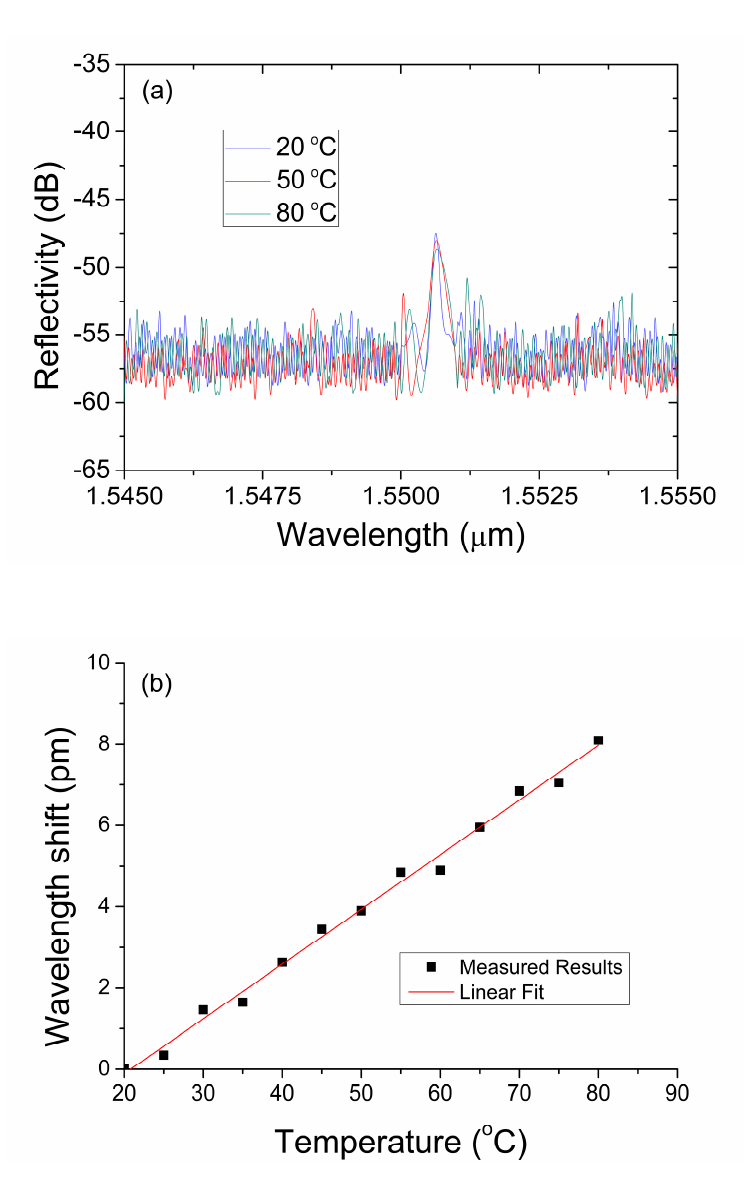
Figure 6. ( a ) Spectrum shift of the sensor with the MF-BG diameter being 2.94 μ m under different temperatures. ( b ) Relation between the wavelength shift and the temperature.